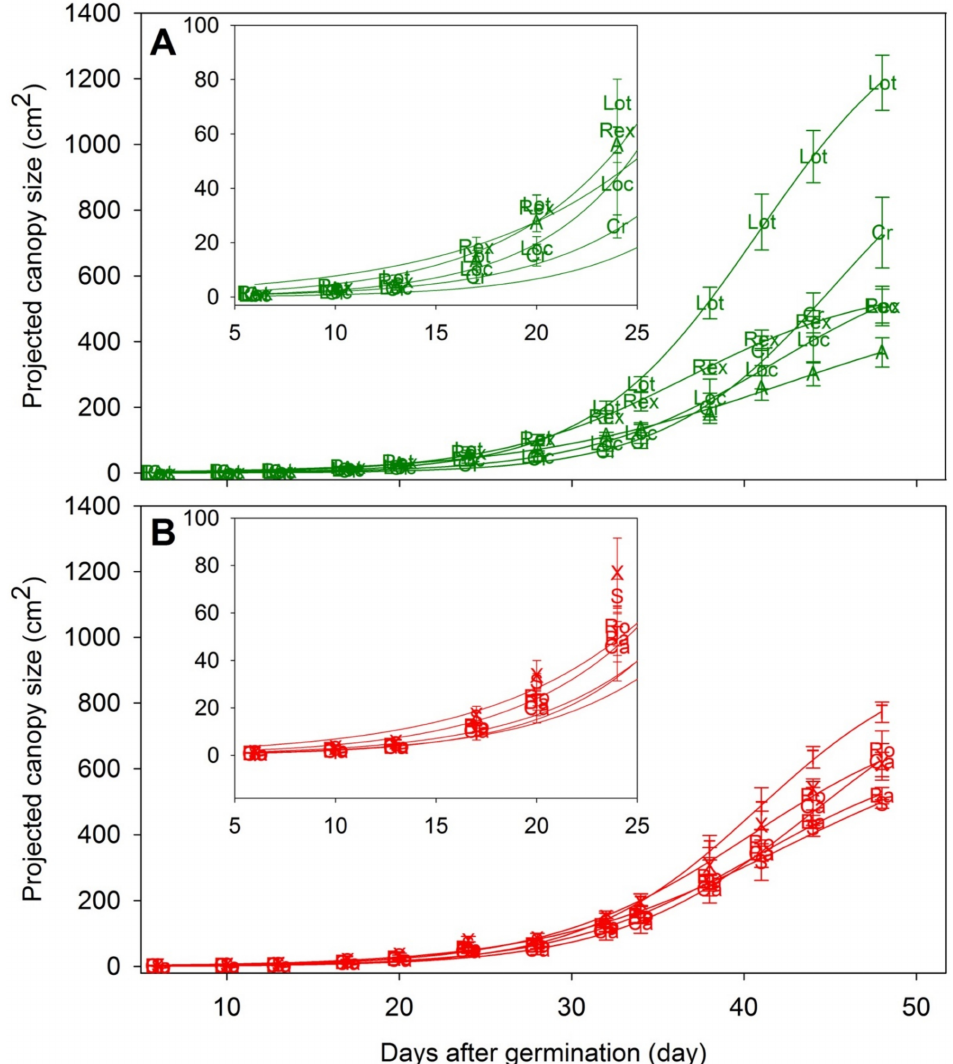
Figure 3. Sigmoidal regression curves of projected canopy size (PCS, R 2 > 0.99) of eleven lettuce cultivars throughout the growing cycle. Green and red colored lines and letters are PCS of green cultivars ( A ) and red cultivars ( B ), respectively. Letters on the plots refer to names of the lettuce cultivars (‘Aquino’ (A), ‘Barlach’ (Ba), ‘Carmessi’ (Ca), ‘Crunchita’ (Cr), ‘Locarno’ (Loc), ‘Lotus’ (Lot), ‘Rex’ (Rex), ‘Rouxai’ (Ro), ‘Seurat’ (S), ‘Teodore’ (T), and ‘Xandra’ (X)). Lettering shows the mean and error bars indicate the standard deviation (n = 10). Inserted plots show the magnified PCS during the early part of the cropping